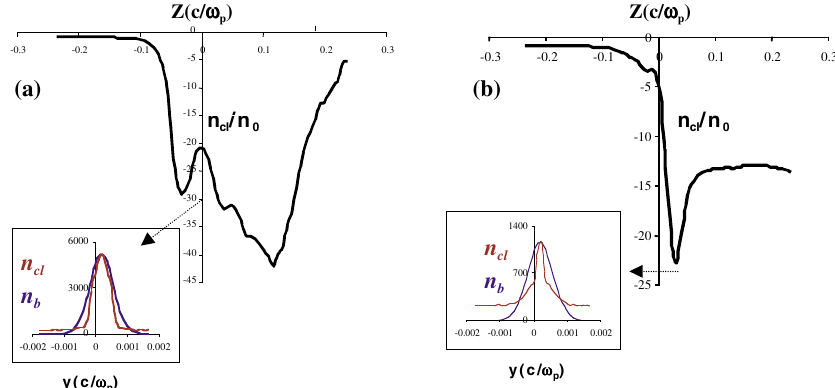
FIG. 11. (Color) Electron cloud line density along the bunch normalized to the unperturbed density for two different values of SPS bunch current. (a) 10 11 p = b case. The transverse density profile is taken along the center of the beam (b) 3 (cid:5) 10 10 case. The profile is taken at the location of maximum cloud compression which is close to the center of the beam. By definition, these figures show the (cid:7) z (cid:8) . In both cases c=! is 5.3 longitudinal profile of the enhancement factor H p cl